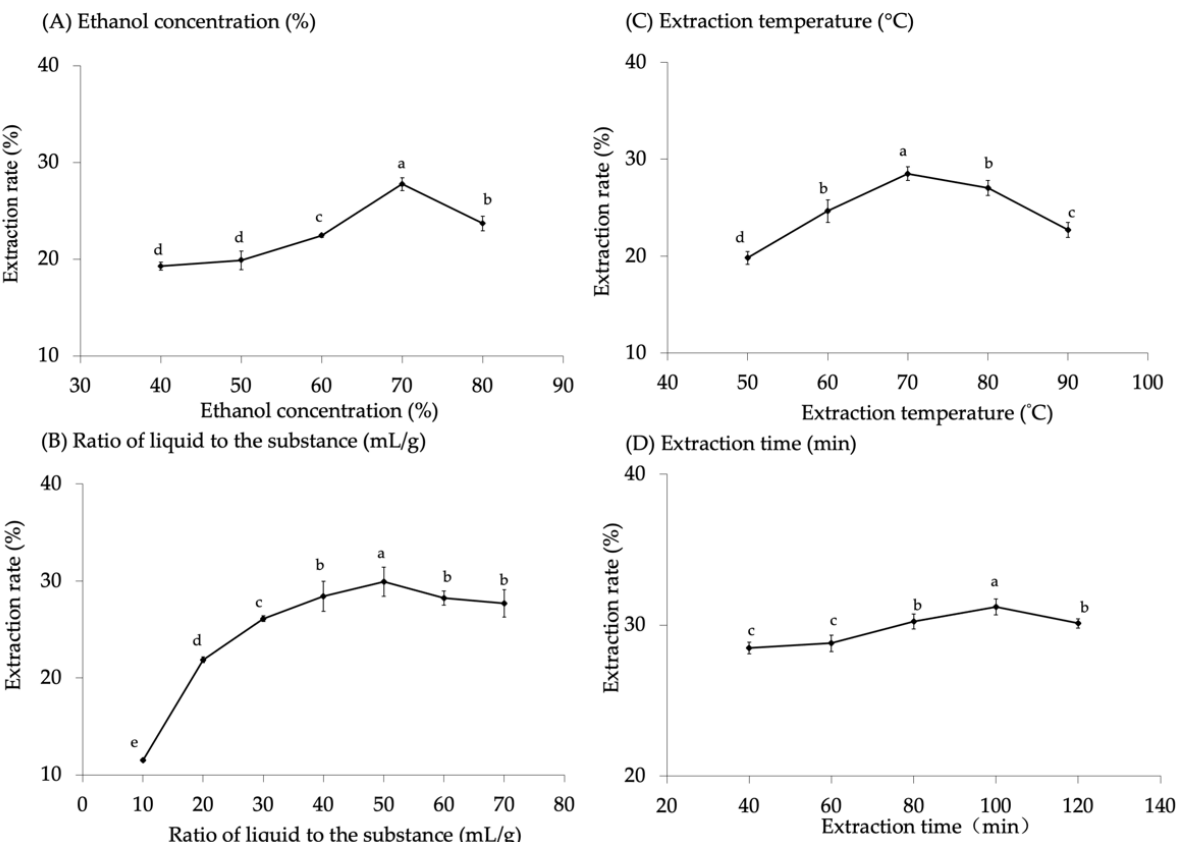
Figure 1. Influence of extraction conditions on total flavonoid extraction rate (%). ( A ) Ethanol concentration (%); ( B ) Ratio of liquid to the substance (mL/g); ( C ) Extraction temperature (°C); and ( D ) Extraction time (min). Different lowercase letters in the figure represent significant differences ( p < 0.05).